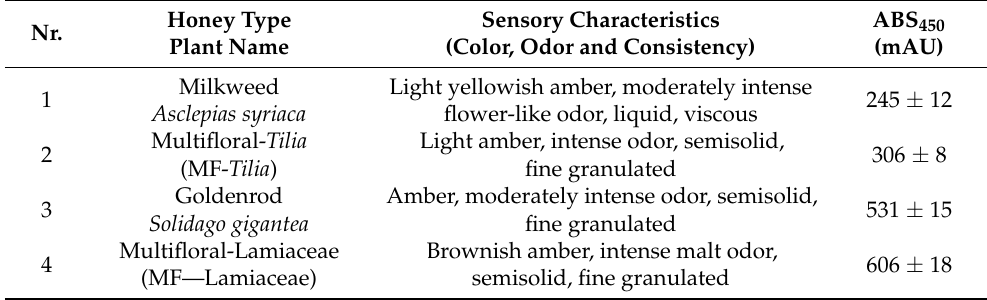
Table 1. Identification, color and sensory characteristics of analyzed honey samples.